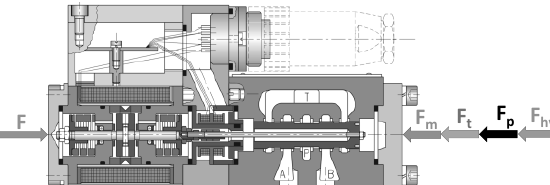
Fig. 4. Axial forces acting on the proportional directional valve spool